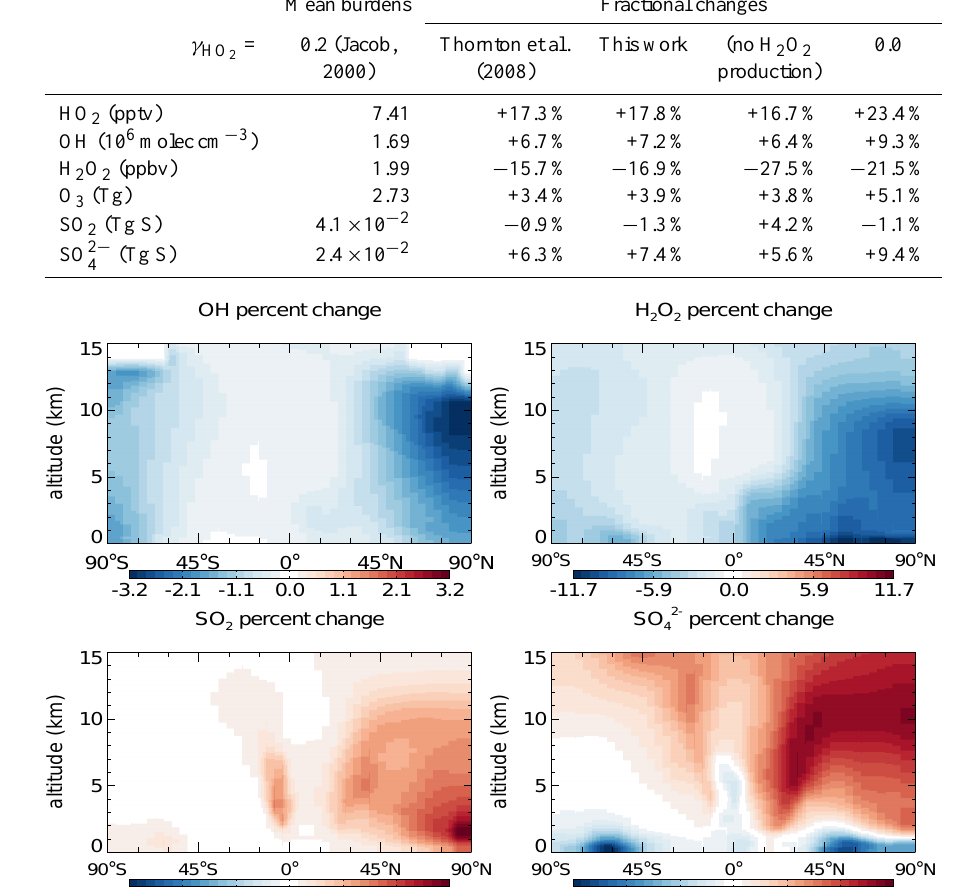
as in Table as in Table 1. Fig. 7. Impact of not producing H 2 O 2 from the heterogeneous reaction of HO 2 , using γ HO 2 2